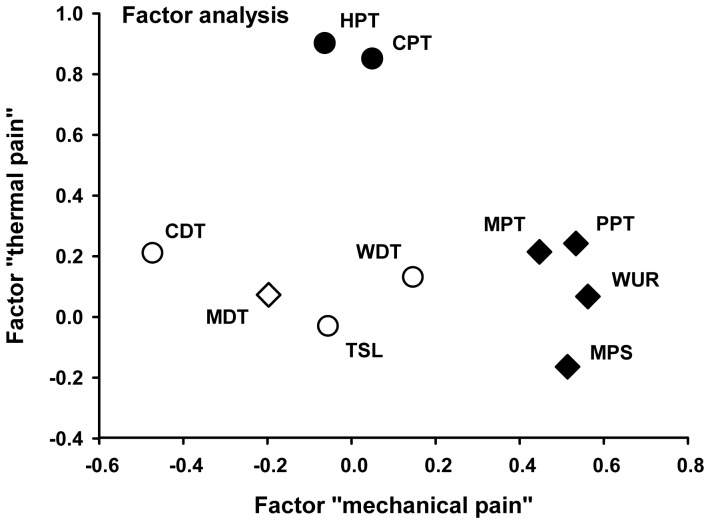
Factor analysis of VARIMAX rotated QST data after 4 Hz matrix array stimulation.All mechanical pain thresholds (MPT, MPS, WUR, PPT) show significant loadings on factor 1 “mechanical pain” (x-axis). Thermal pain thresholds show significant loadings on factor 2 “thermal pain” (y-axis), while thermal and mechanical detection thresholds take an intermediate position, indicating that 4 Hz stimulation differentially effects different peripheral and central sensory channels to the brain.